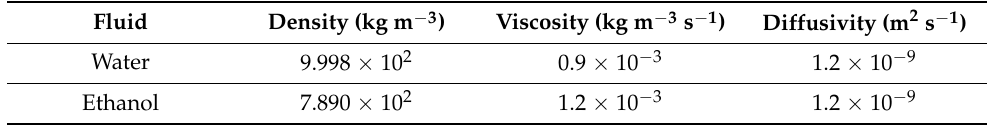
Table 1. Main physical parameters of the two fluids for